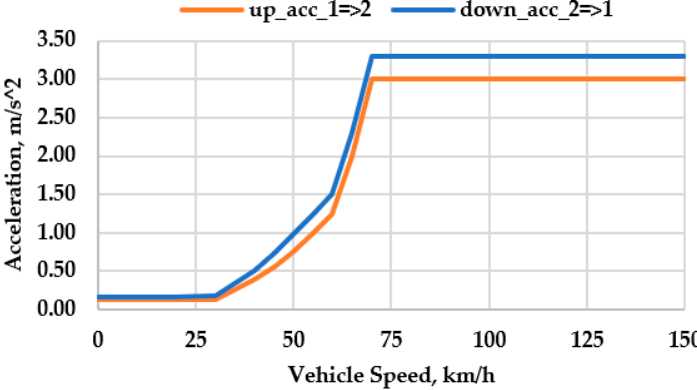
Figure 5. Gearshift schedule map based on the vehicle acceleration.